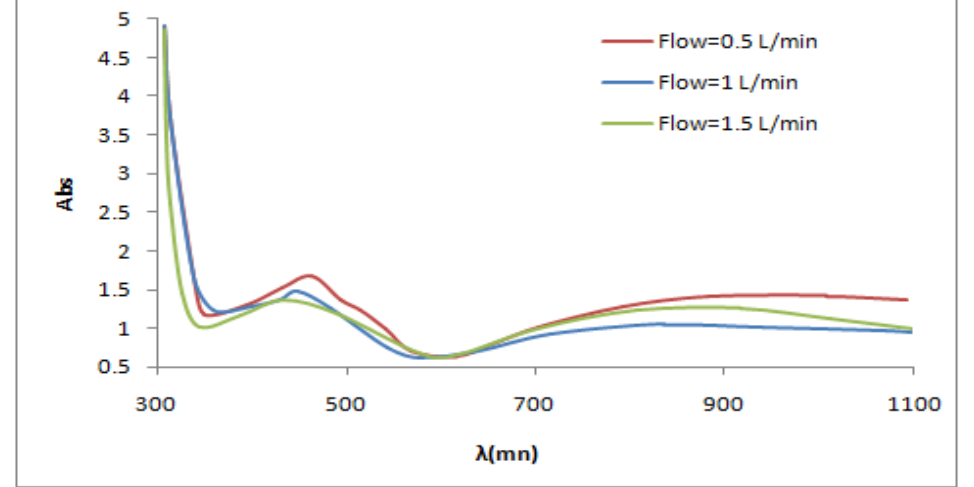
Fig.4: Absorption spectra of polypyrrole films at (0.5, 1 and 1.5) L/min argon gas flow